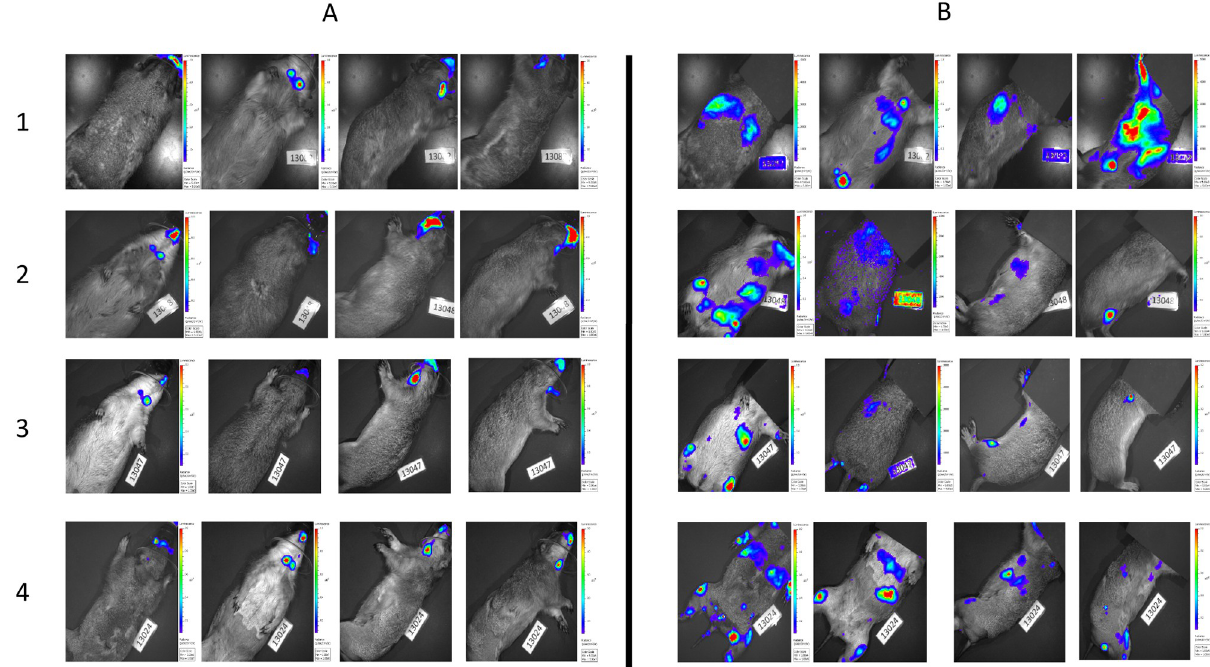
Fig 2. Covering initial infection site with construction paper identifies other areas of viral replication during early infection. Images are black and white photograph of a representative prairie dog taken at each time point overlaid with a false color representation of photon emission intensity as indicated by the scale on the right in ps -1 cm -2 sr -1 . Individual animals 1 through 4 were imaged on day 6 post infection after injection with D luciferin. Column A represents images taken of animals with the nose area uncovered while column B shows the same animals imaged with the nose area covered by black construction paper to block the stronger